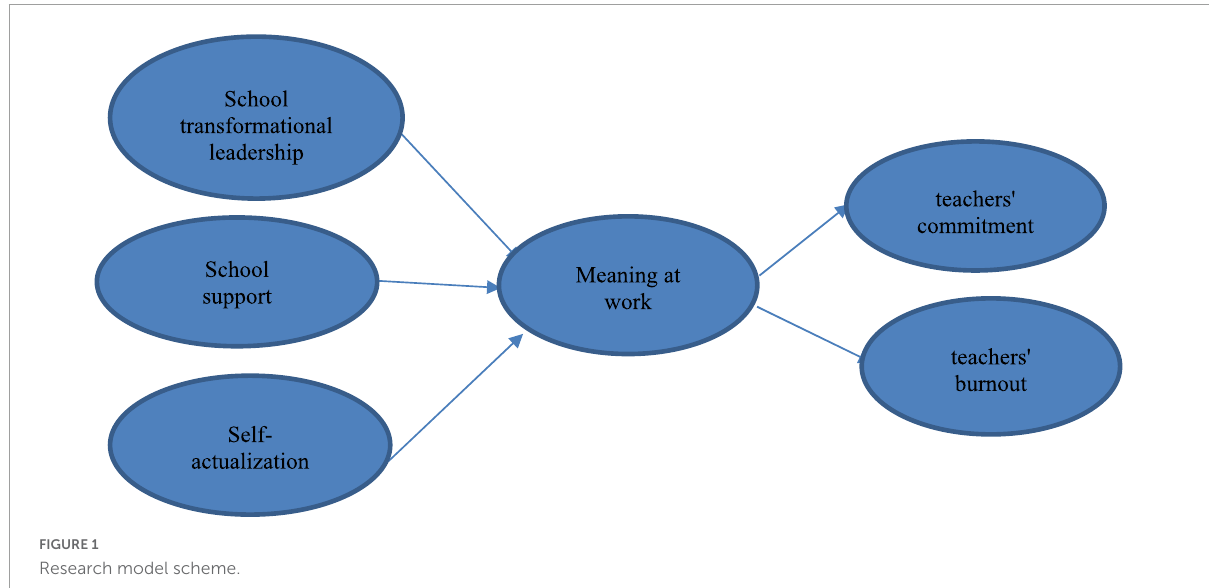
FIGURE1 Research model